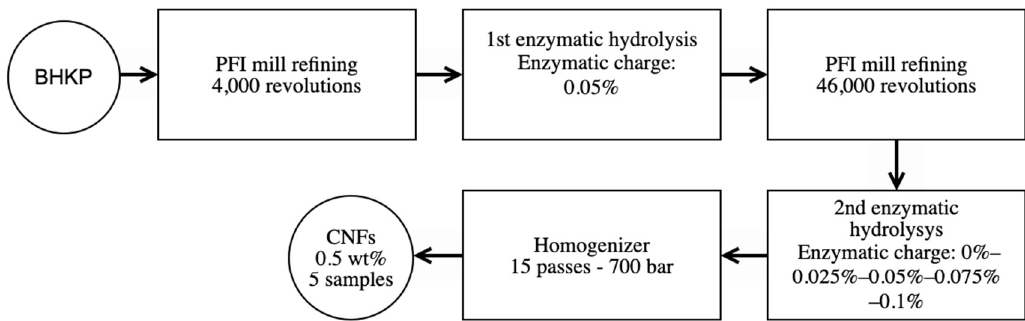
Figure 1. Experimental design flow chart.